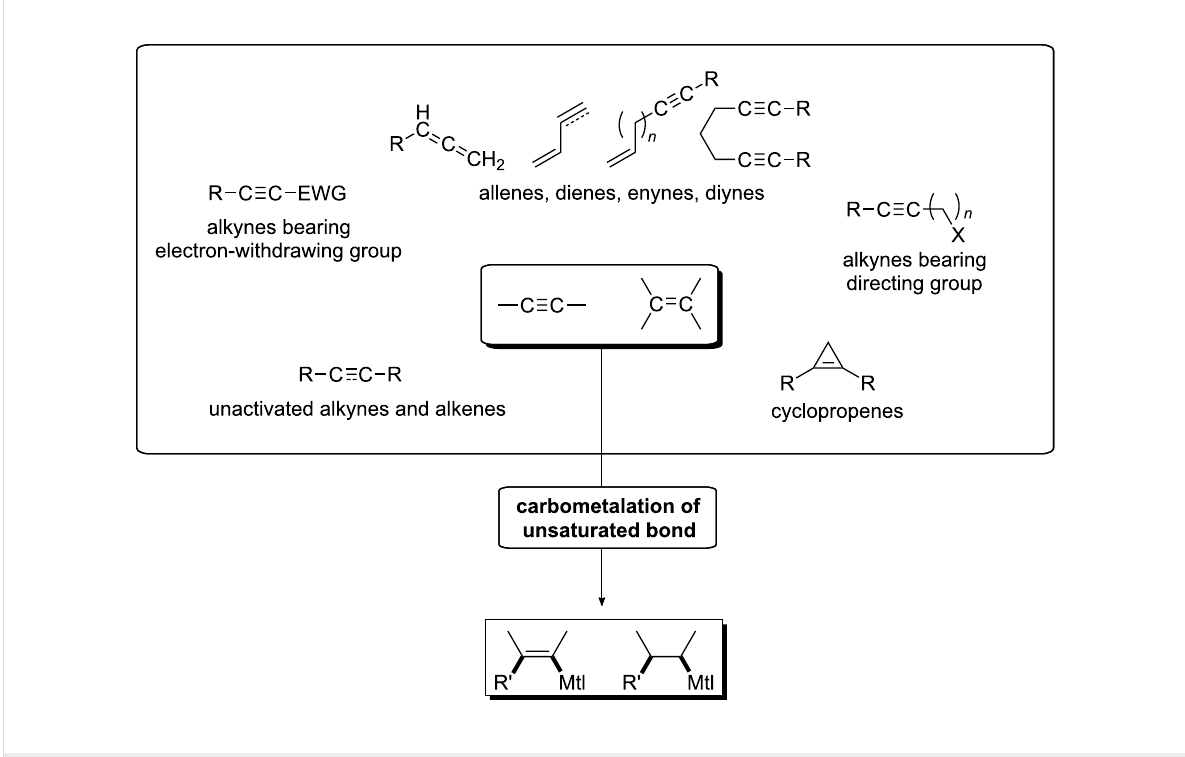
Scheme 1: Variation of substrates for carbomagnesiation and carbozincation in this